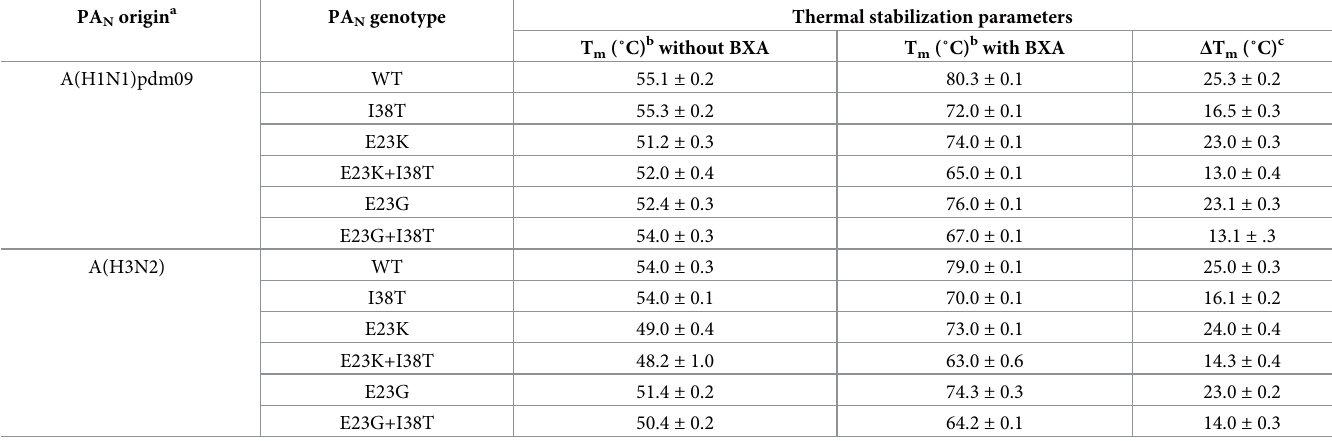
Table 4. Thermal stabilization of E23X E23G/K and/or I38T-substituted PA N by